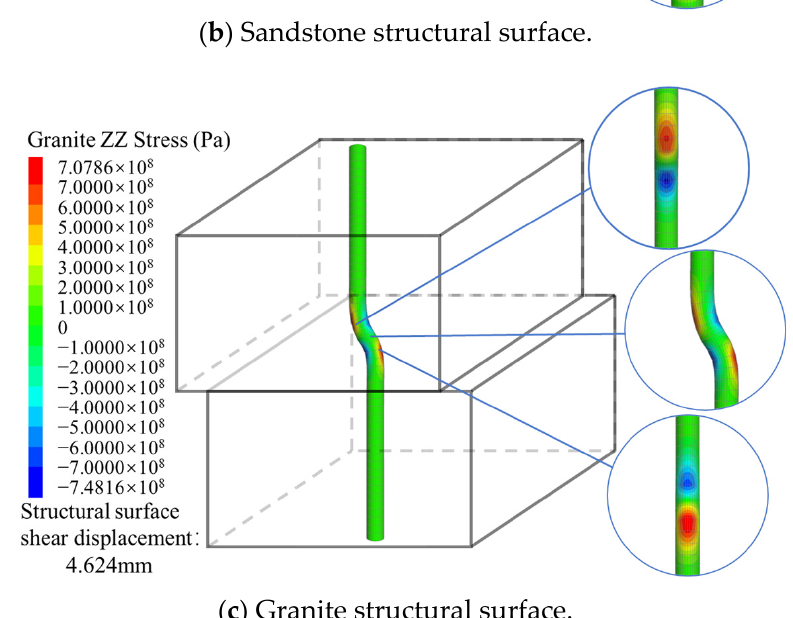
Figure 11. Axial stress distribution at bolt yield (Pa). The distributions of the average axial stress and average shear stress along the length of the bolt when it yielded in the structural surfaces of coal, sandstone, and granite rock are shown in Figure 12. It can be seen that the areas where deformation occurred on the bolt were mainly concentrated near the structural surface, and the maximum value of